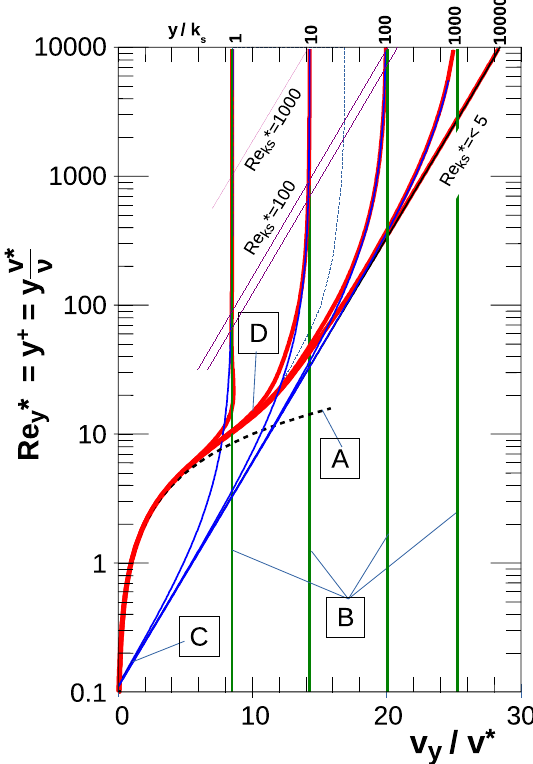
Figure 5. v y / v (cid:63) at level y / k s as a function of Re (cid:63) y . A = viscous sublayer Equation (30), B = Equation (27), C = Equation (28), D = Equation